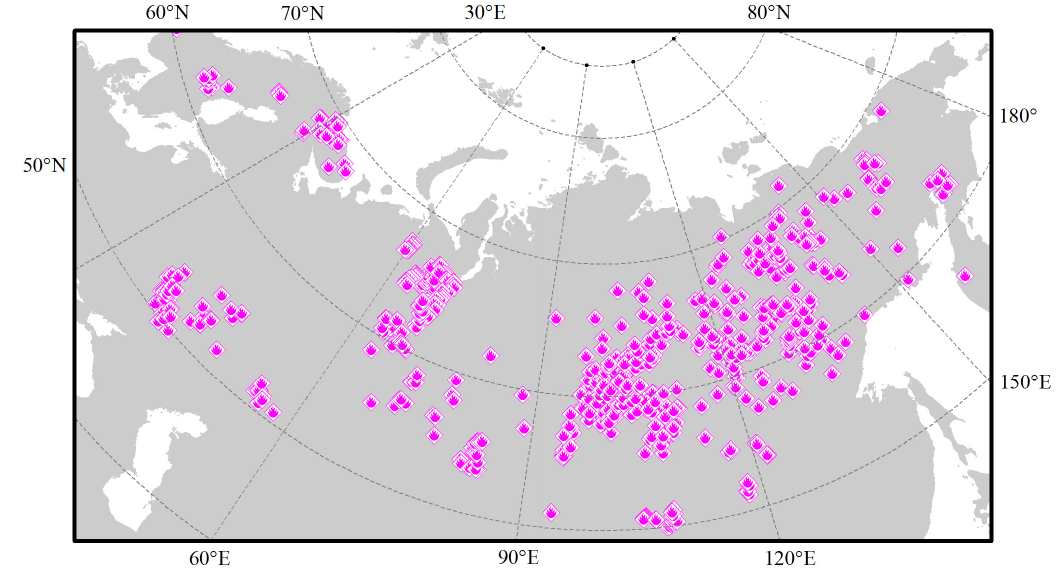
Figure 3. Spatial distribution of the 719 fires mapped (magenta diamonds). Of the 719 fires, 442 fires were in the region above 60°N, in the main study area, and the remaining 277 fires were located in the region below 60°N.